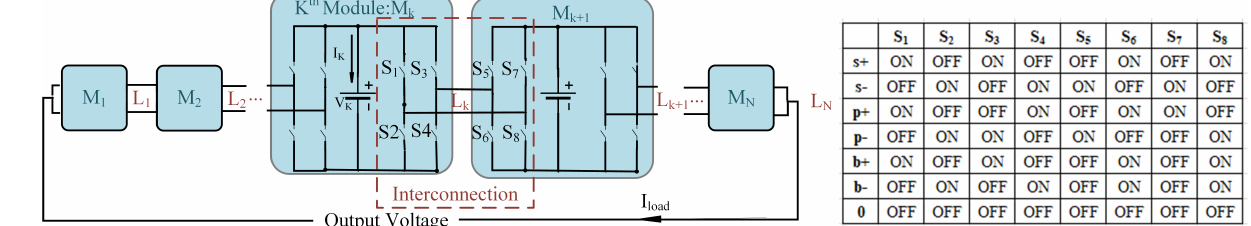
Figure 2. Battery block consisting of N modules; module k consisting of a cell and an MMSPC, along with switches S 1 – S 8 to effect the interconnection between modules k and k+1. The table shows the seven possible combination of the switching states of S 1 – S 8 and their turned ON and turned OFF switches,